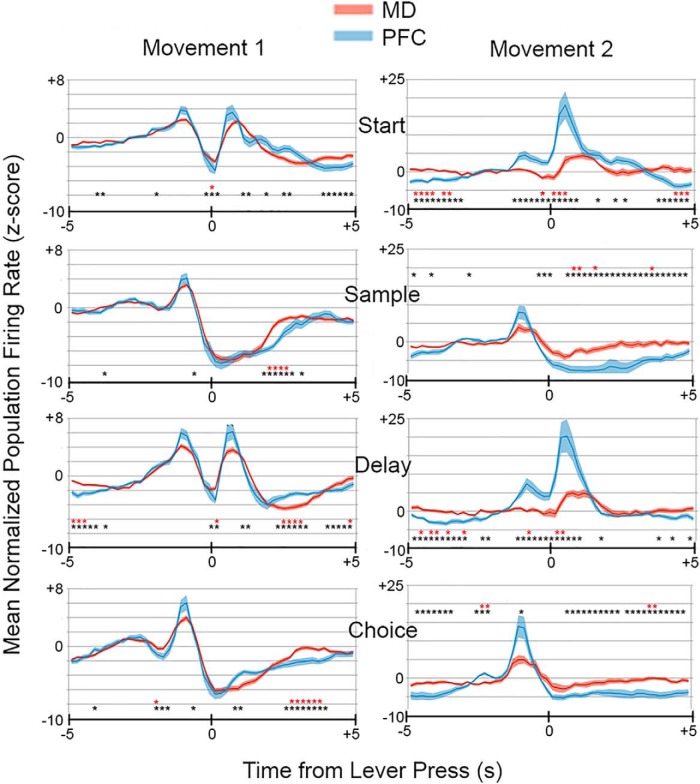
Normalized population responses for movement 1 and 2 responses in MD and PFC. Results are plotted from 5 s before until 5 s after start, sample, delay, and choice lever presses in 200-ms time bins. Results show average activity of 91 neurons in MD and 68 in mPFC with movement 1 responses and 14 neurons in MD and 13 in mPFC with movement 2 responses. Black asterisks indicate time bins that differed at p < 0.05 and red asterisks bins that differed at p < 0.001 (Bonferroni correction for α = 0.05) for two-tailed Mann–Whitney tests. Thin dark lines represent the mean; wider light colored lines the SEM.